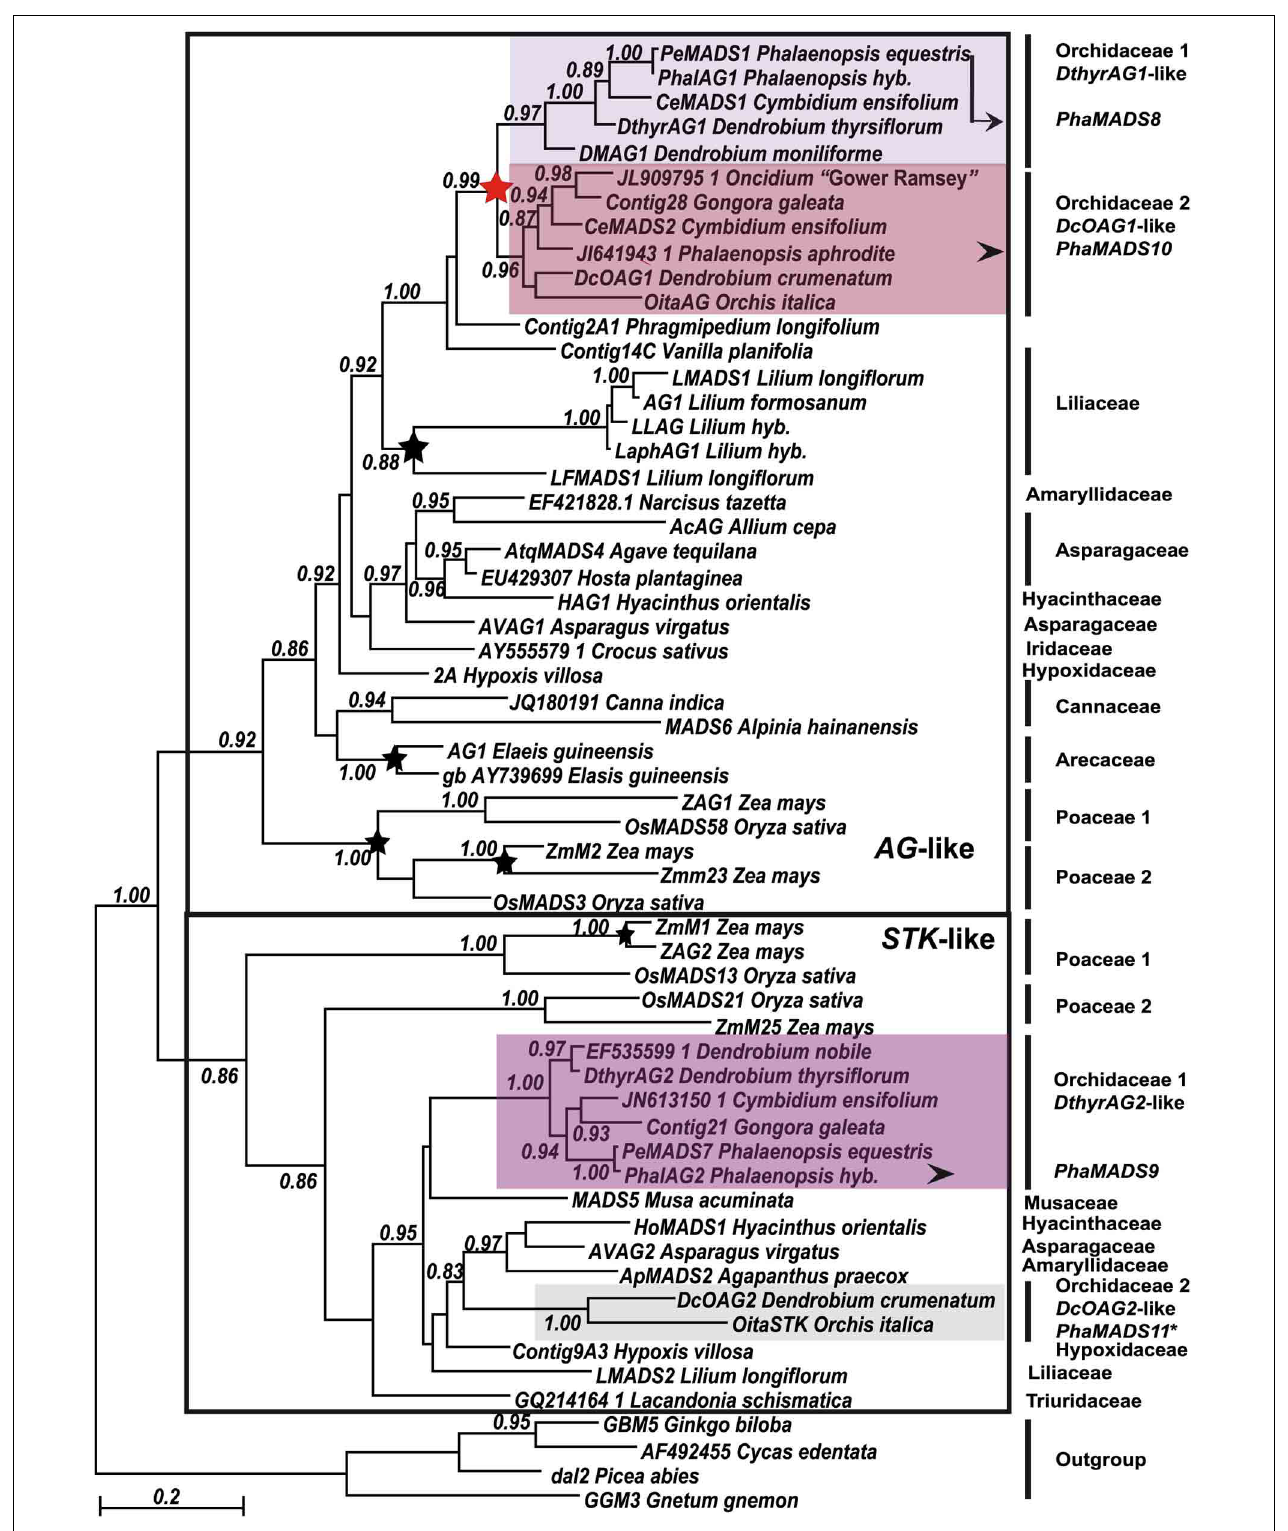
FIGURE 4 | Maximum Likelihood phylogeny of monocot AG - and STK -like genes. Major monocot clades previously identified are indicated with a black frame (Kramer et al., 2004). Orchidaceae-specific clades and other annotations are as described in Figure 2 .